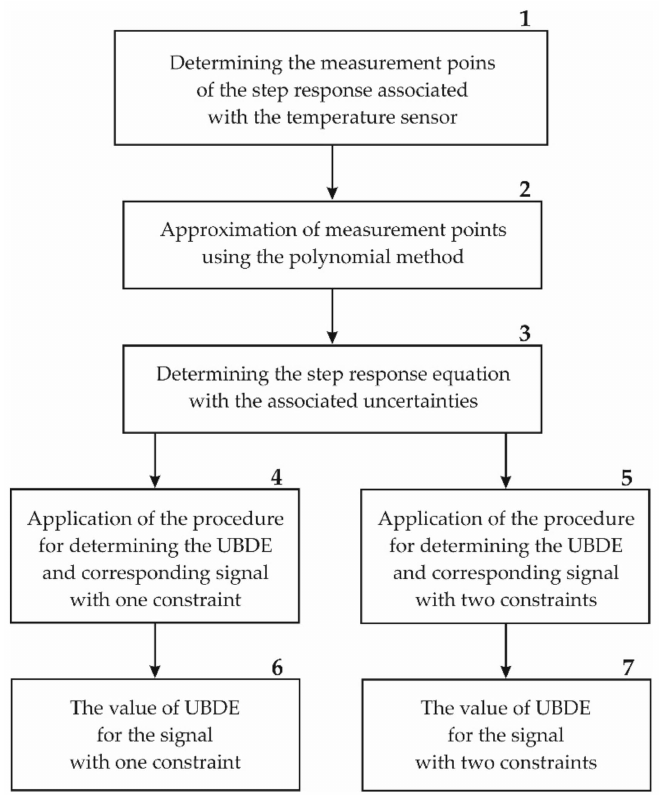
Figure 1. Block diagram for the analysis of the upper bound of dynamic error (UBDE) during temperature